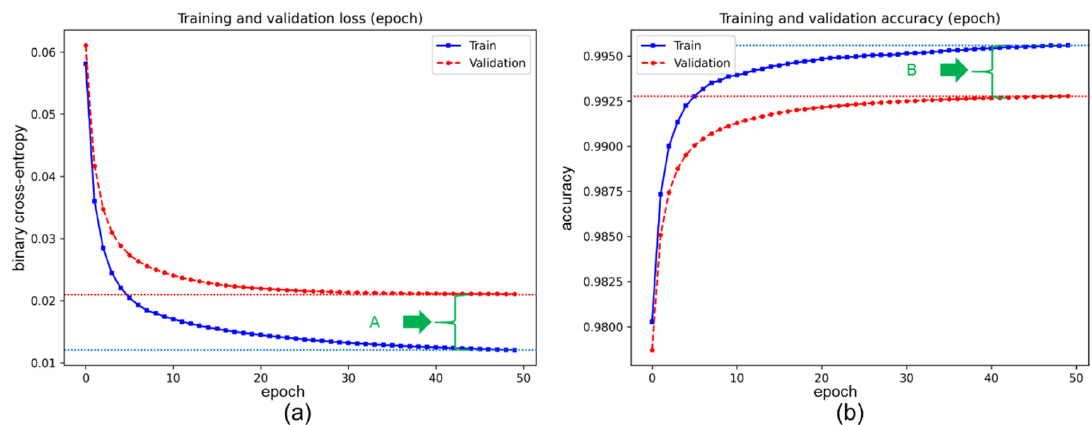
Figure A5. The loss and accuracy curves of U-Net++ [15] using the synthetic dataset. The green “A” and “B” correspond to the two highlights mentioned in Section 3.2. ( a ) Refers to the epoch-wised loss curves in the training and validation sets. ( b ) Refers to the epoch-wised accuracy curves in the training and validation sets. The horizontal dash lines refer to the references of final converge status.